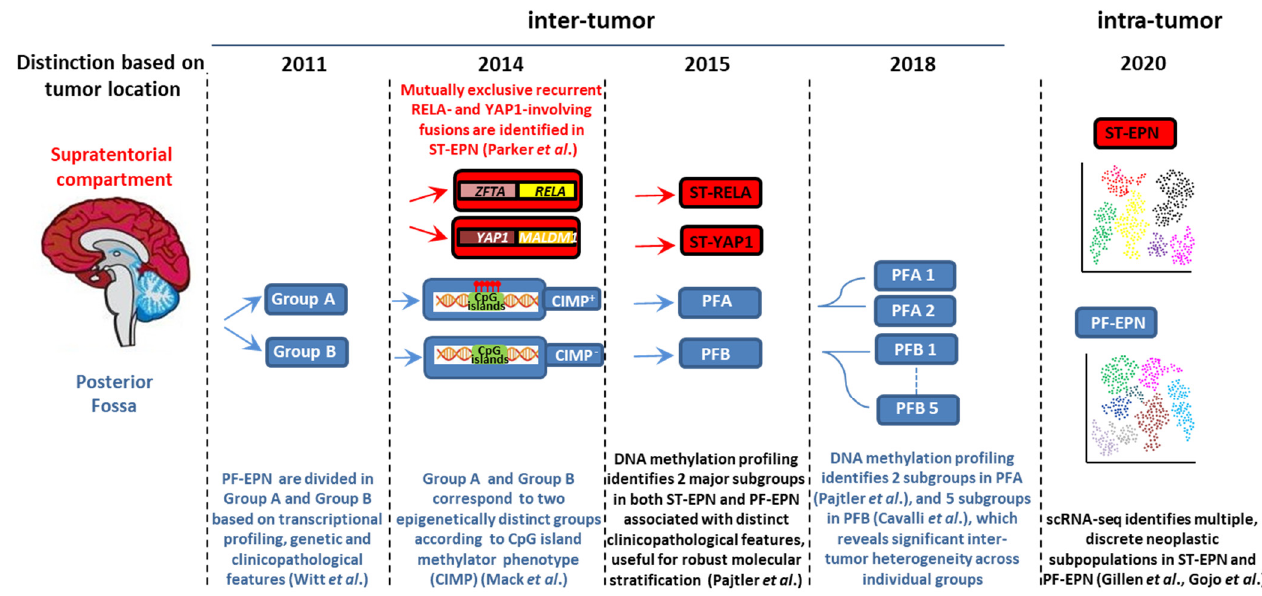
Figure 1. A timeline of the most important molecular findings which have contributed to uncovering inter-tumor and intra-tumor heterogeneity in intracranial pediatric ependymoma.